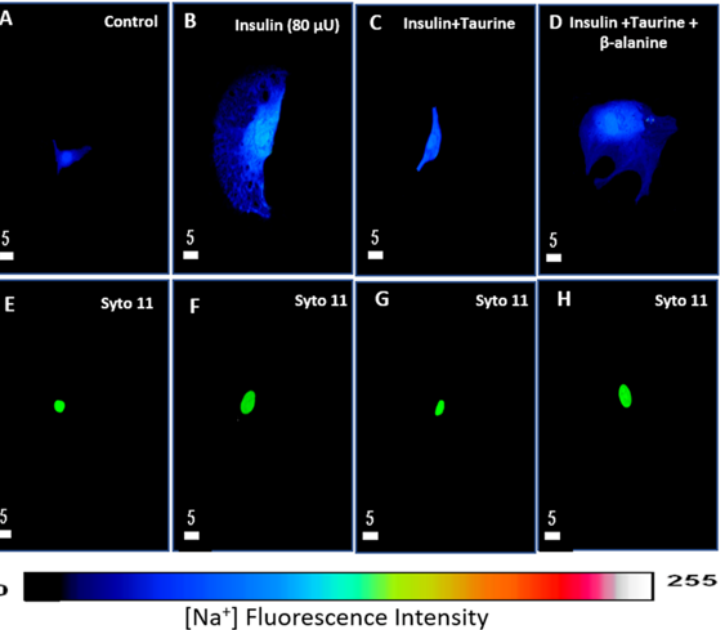
Figure 4. Examples of quantitative 3-D confocal images (top view) showing the distribution and fluorescence intensity of intracellular sodium in cardiomyocytes in the absence of treatment ( A ), in the presence of insulin (80 μ U/mL) ( B ), in the presence of insulin (80 μ U/mL) + taurine (20 mM) ( C ), and in the presence of insulin (80 μ U/mL) + taurine (20 mM) + β -alanine (500 μ M) ( D ). Panels ( E – H ) represent the Syto-11 labeled nuclei of the cells in panels ( A – D ). The pseudo-color bar represents Na + fluorescence intensity ranging from 0 (absence of fluorescence) to 255 (maximum fluorescence). The white scale bar is in μ M.